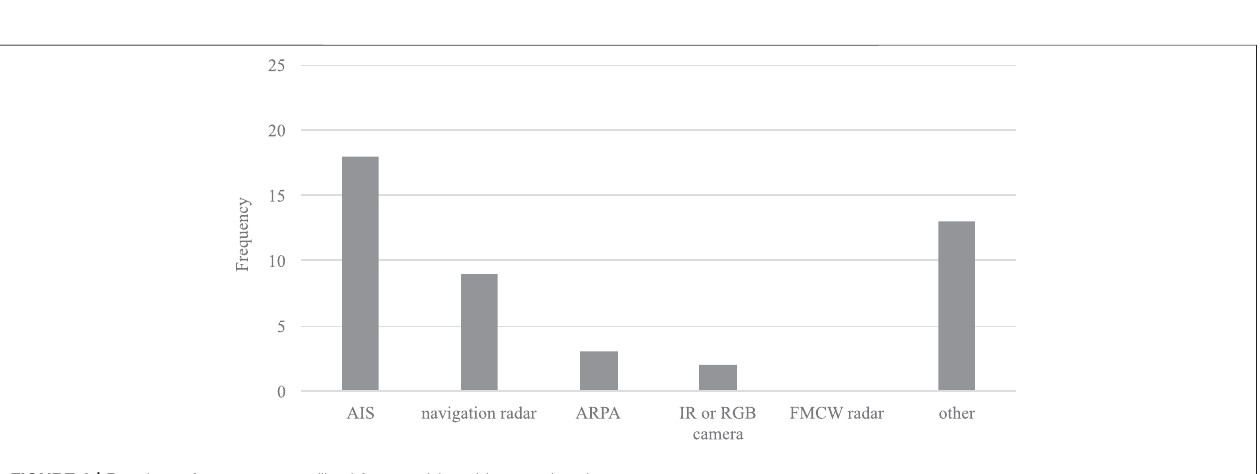
FIGURE 6 | Bar chart of sensor types utilized for perceiving objects and